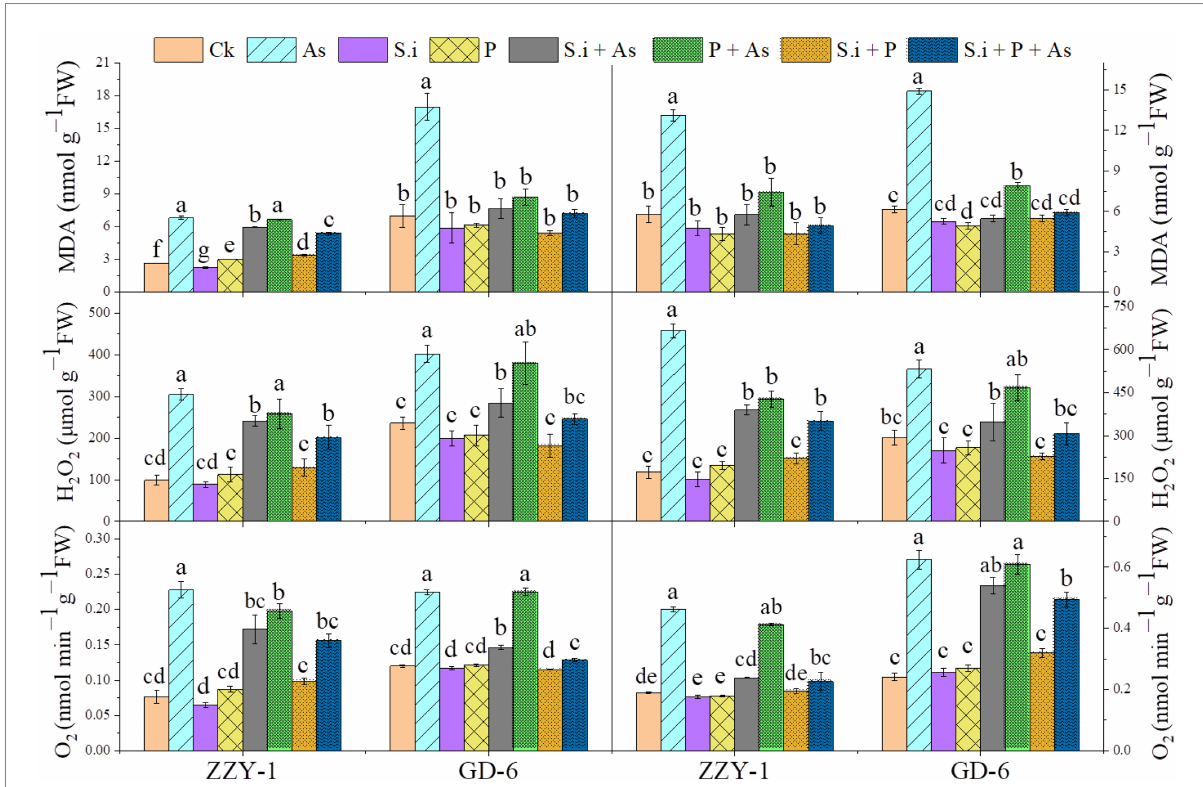
FIGURE 6 Arsenic stress-mediated oxidative burst amelioration through alone and combined interactions of Serendipita indica symbiosis and phosphorus application in two rice genotypes differing in As accumulation tendency. Right panel represent root and left shows analysis of ROS levels in leaves. Vertical bars represent the means of three independent replicates (±SE). Different letters represent significant difference ( p ≤ 0.05) among the treatments within each